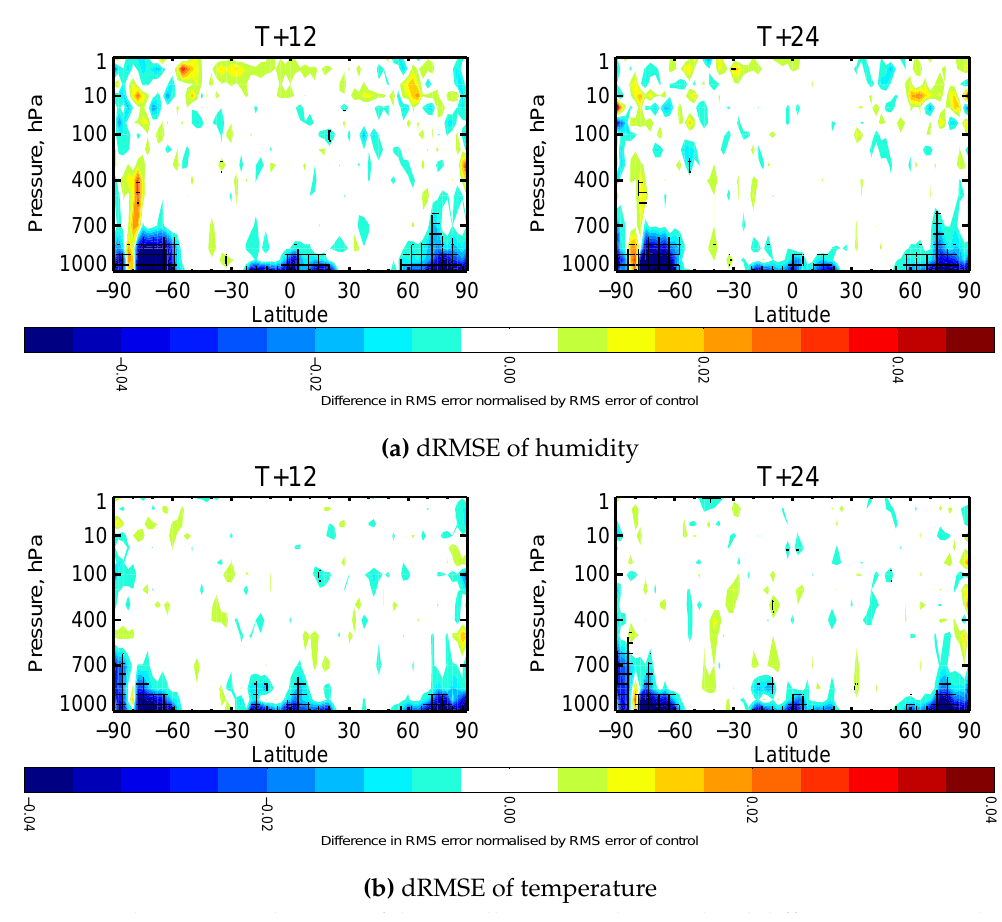
Figure 6. Latitude–pressure diagram of the zonally averaged normalised difference in RMSE between WCDA and control for humidity (top) and temperature (bottom) forecasts at 12h (left) and 24h (right) lead times, for the period 20170609 to 20180521. Hashed areas indicate statistically significant differences.